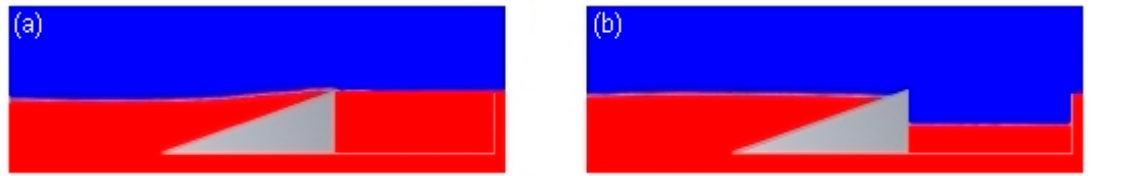
Figure 20. Fluid-dynamic behavior referring to the RG coastal region for t = 900 s and considering the incidence of ( a ) representative regular waves and ( b ) realistic irregular waves.